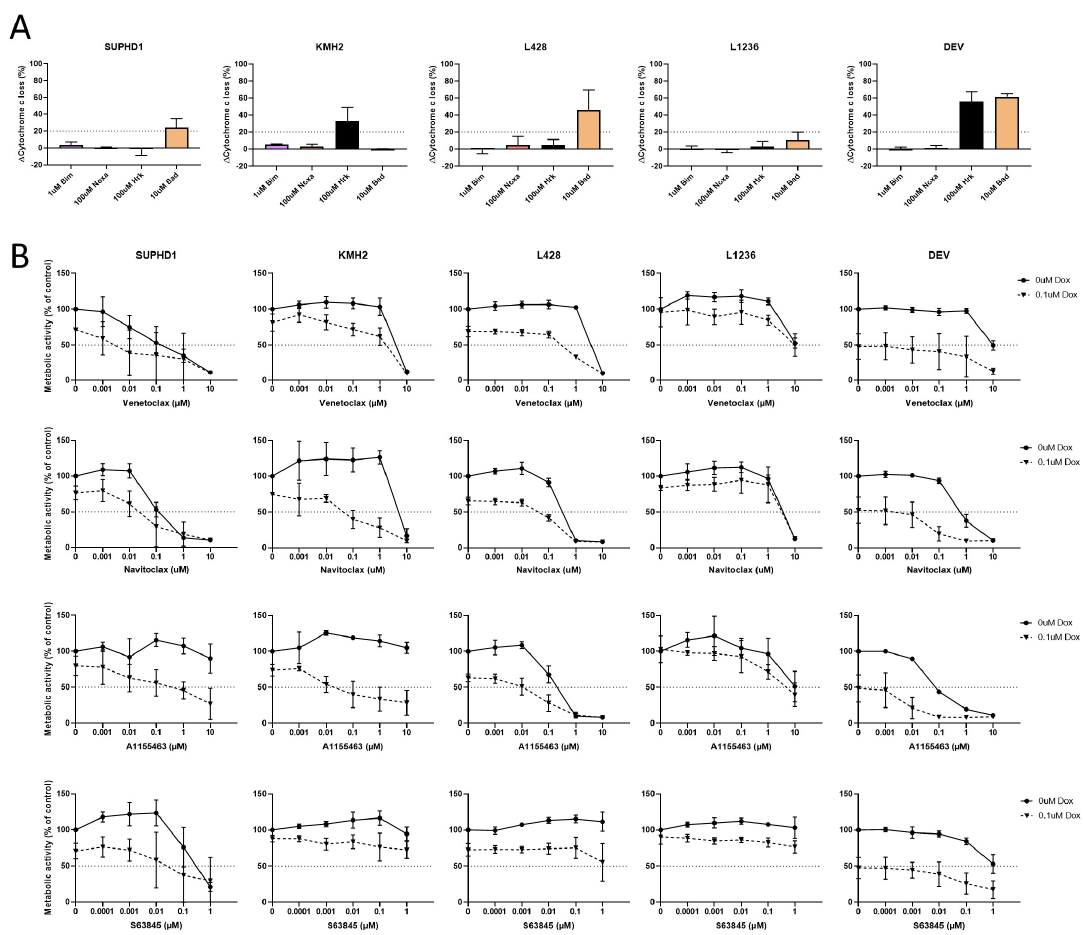
Figure 3. Combination therapy with doxorubicin and BH3 mimetics in HL cell lines. ( A ). Dynamic BH3 profiles for HL cell lines after doxorubicin treatment. Δ MOMP % against 1 µM BIM, 100 µM NOXA, 100 µM HRK, and 10 µM BAD. ( B ). Combination therapy of 0.1 µM doxorubicin with venetoclax, navitoclax, A1155463, and S63845 in HL cell lines. Results are given as metabolic activity normalized to untreated cells. Table 3. Overview of the effect of doxorubicin treatment on HL cell